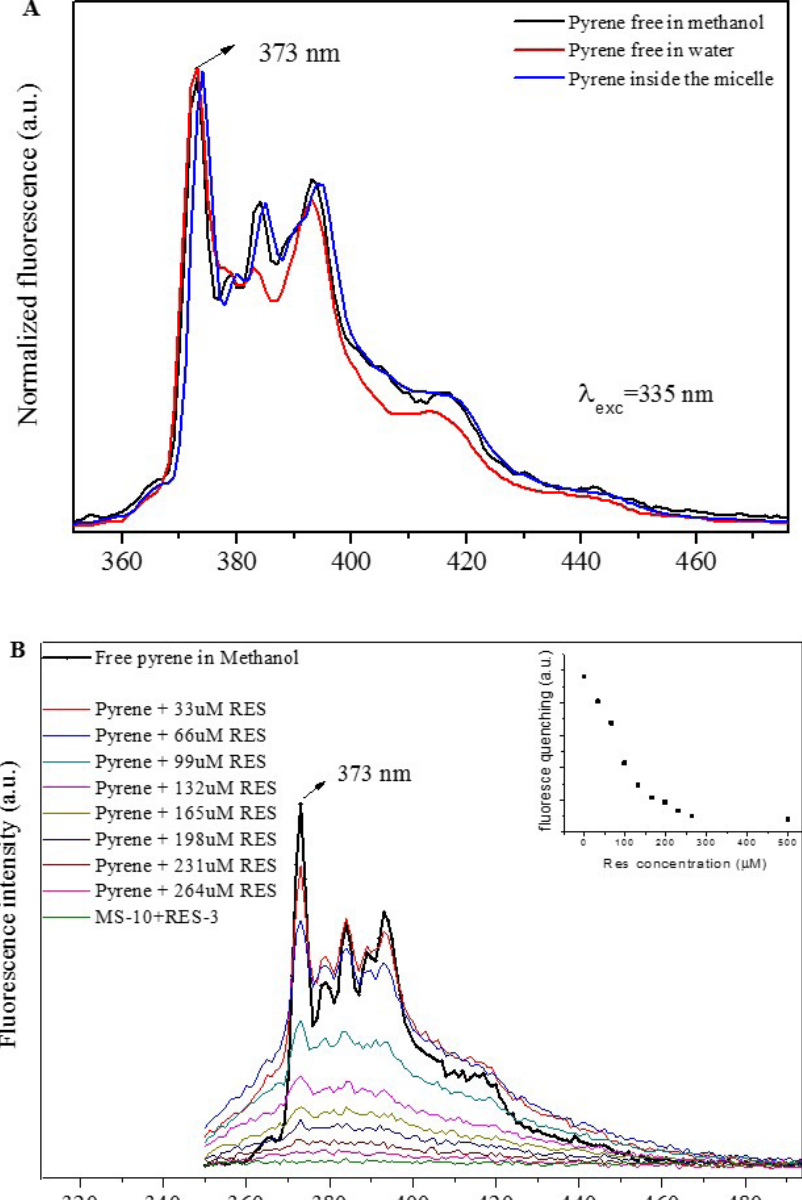
FIGURE 2 - Micellar microenvironment analysis using pyrene as a fluorescent probe. (A) Pyrene emission spectra in water, methanol and inside the micelles. (B) Pyrene emission spectra in presence of resveratrol and inside the formulation MS-